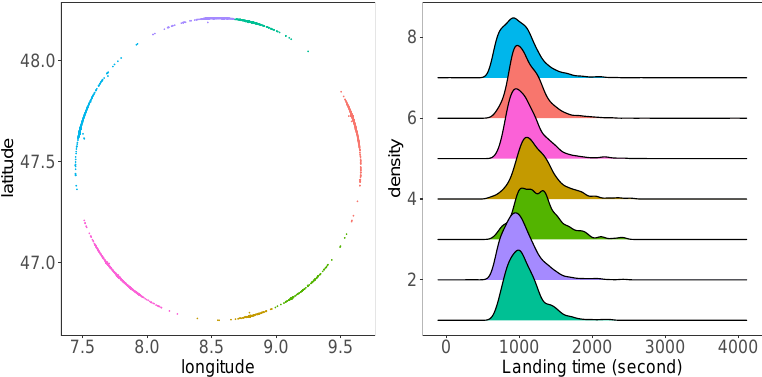
Figure 3. K-means clustering and landing time by clustering. (Left) Clustered entry points with the radius as 45 NM; (right) density plot of landing time grouped by K-means